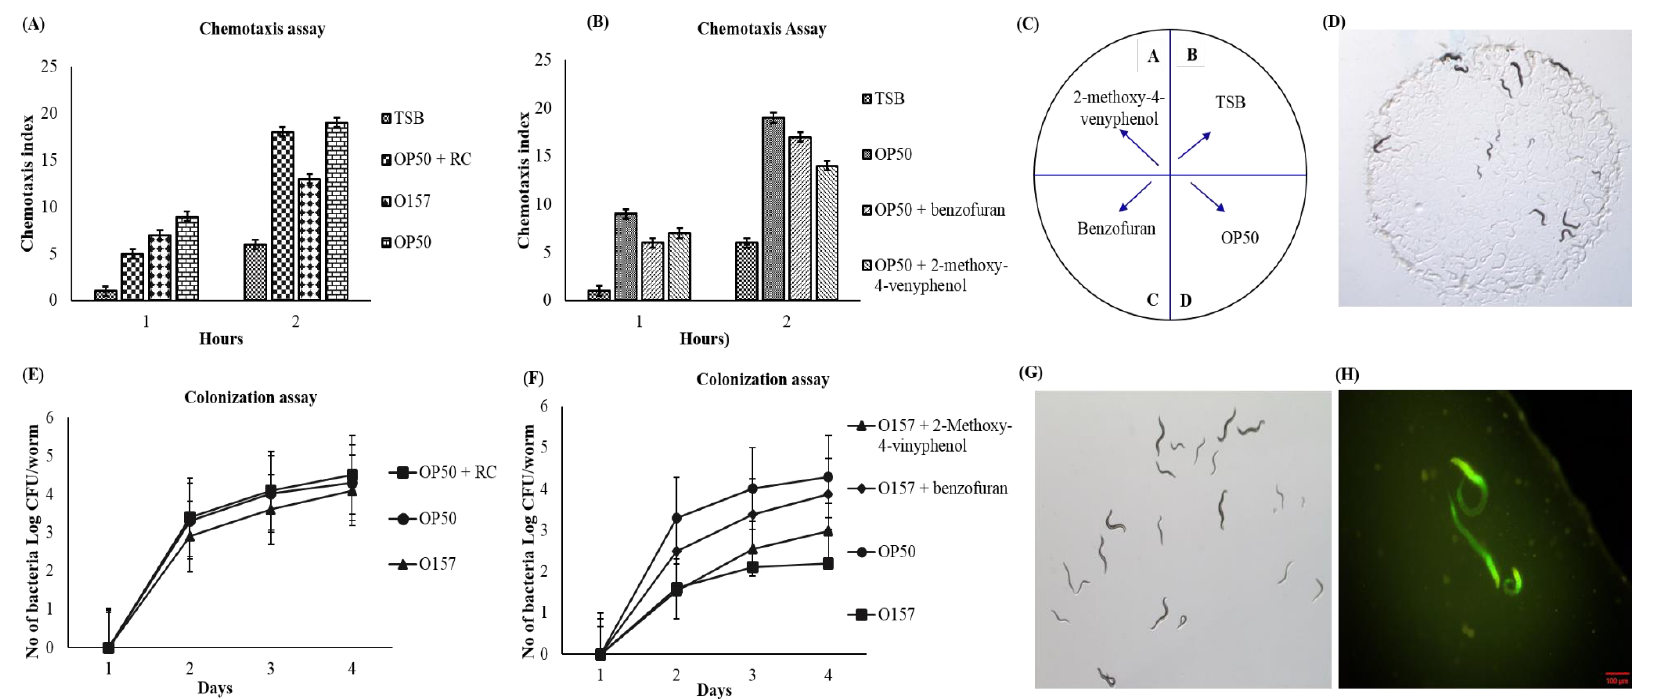
Figure 3. ( A ) Chemotaxis assay of RC extract compared between E. coli 0157 and E. coli OP50 (basic food for worms), ( B ) chemotaxis assay compared between OP50 and commercially available identified compounds; 2-methoxy-4-vinyphenol and benzofuran combined with OP50, respectively. ( C ) The model chart of chemotaxis assay. ( D ) Chemotaxis assay plate indicates the from the center of the plate worm move towards the test sample equally when compared with control (OP50). ( E ) Colonization assay indicates the durability of the work when fed [Pathogen— E. coli O157, and Plant extract (RCC extract)]. ( F ) Colonization assay indicates the durability of the work when fed [Post treatment of 2-methoxy-4-vinyphenol against pathogen— E. coli O157 + benzofuran against pathogen— E. coli O157 + 2,3 and E. coli 0157 (pathogen)]. ( G ) Stereomicroscopic image on the Morphology of C. elegans after the colonization assay. ( H ) The stereomicroscopic image indicates the green spots (Syto-9) healthy live cells of the C. elegans after the colonization assay.